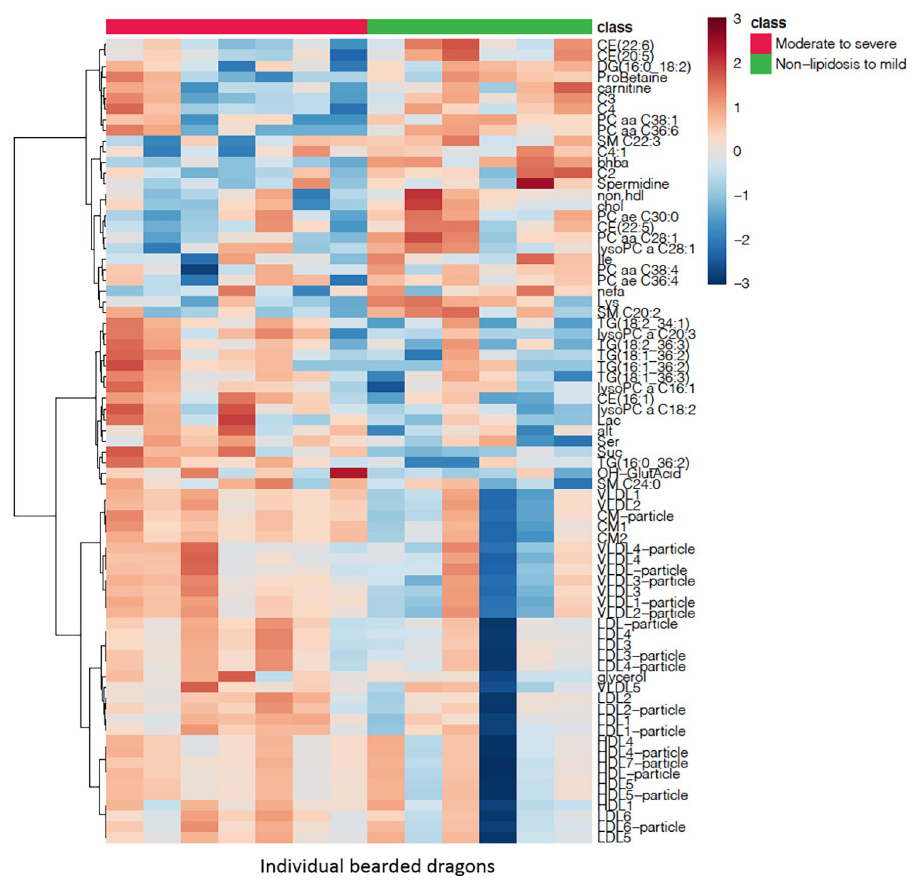
Fig 6. Score plot of sparse partial least square- discrimination analysis (sPLS-DA) analysis of metabolomics, lipidomics, and biochemistry data between the 2 first principal components in bearded dragons with 2 simplified classes of hepatic lipid changes (no-lipid to mild and moderate to severe) in bearded dragons based on an established grading system [30]. The right panel shows the loadings plot for the first component showing the most important variables for